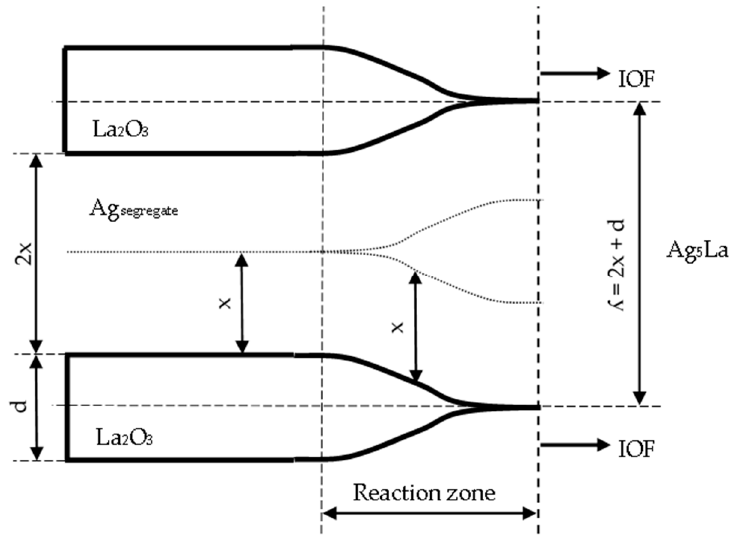
Figure 15. The model of oxide thickening in the reaction zone of the “Big Ag 5 La particles” at the internal oxidation front.